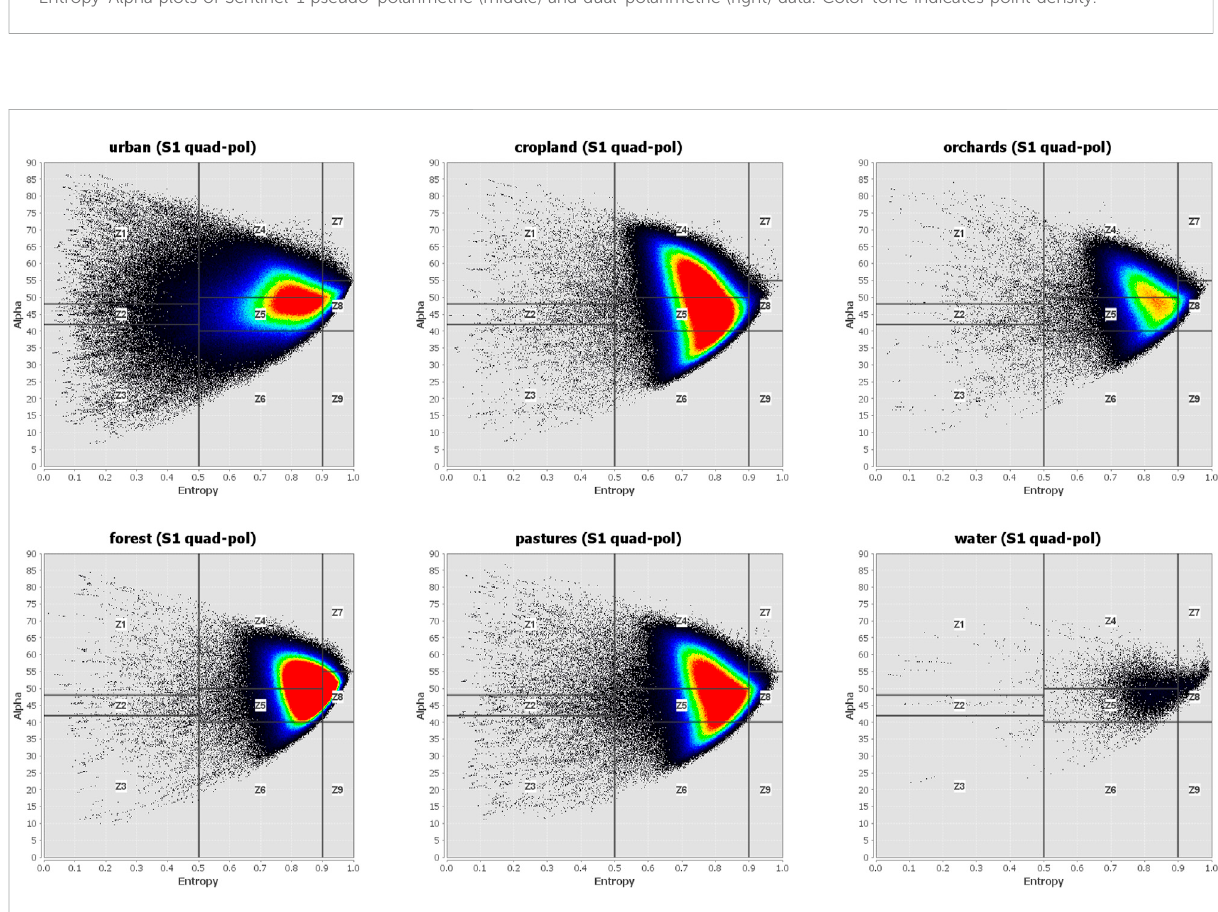
FIGURE 9 Entropy-Alpha plots of selected classes retrieved from Sentinel-1 pseudo-polarimetric data. Forest and urban classes were aggregated for this